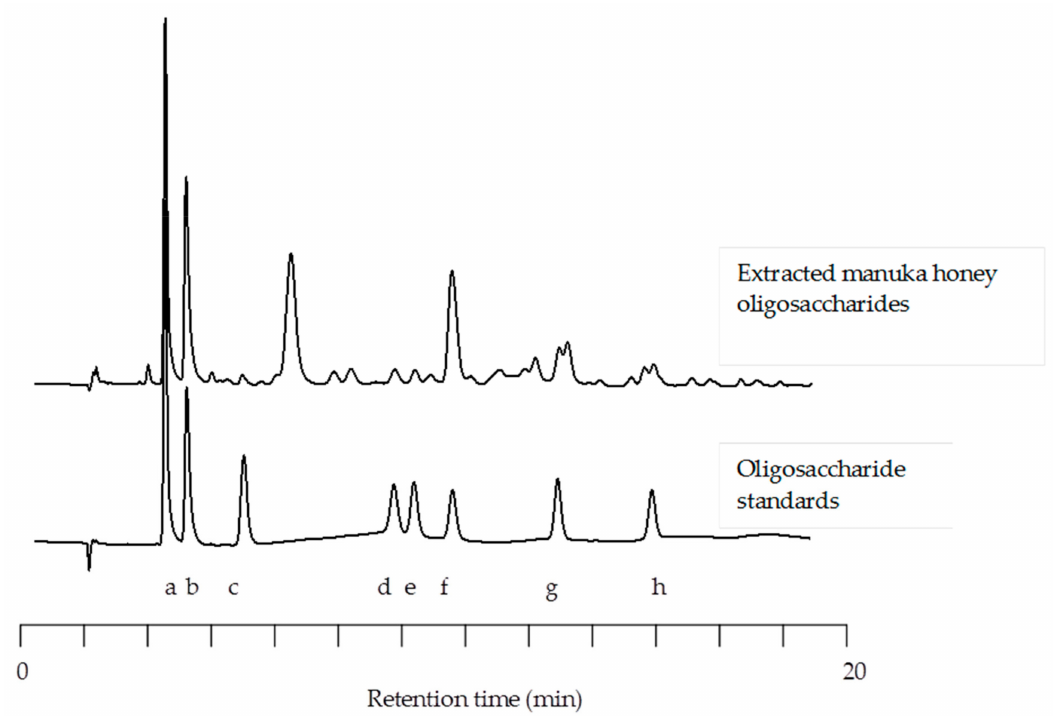
Figure 1. Comparative high performance anion-exchange chromatography with pulsed amperometric detection (HPAEC-PAD) chromatographs of manuka honey oligosaccharides with commercially available standards (Glucose ( a ), Fructose ( b ), Kojibiose ( c ), Nigerose ( d ), Maltose ( e ), Erlose ( f ), D-Panose ( g ), and Maltotriose ( h